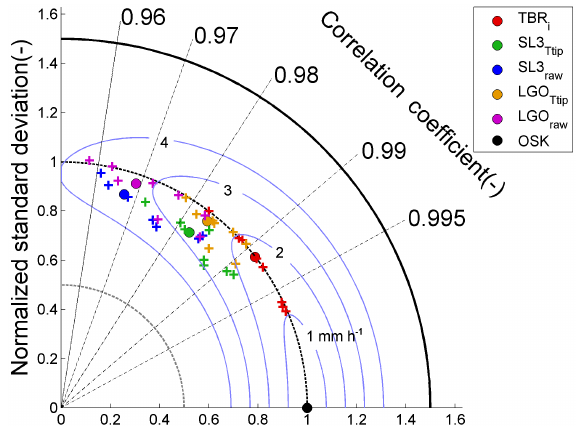
Figure 7. Taylor diagram representation of pattern statistics of the various RI series. The radial distance from the origin is proportional to the normalized standard deviation of the RI signal; the blue con- tour lines highlight the RMSE difference from the OSK reference (black dot) for each recorded event; the azimuthal position indicates the correlation coefficient between the RI signal and the reference. Crosses indicate the statistics of each single event, while the dots in- dicate the average values of the whole campaign (colours according to the legend).